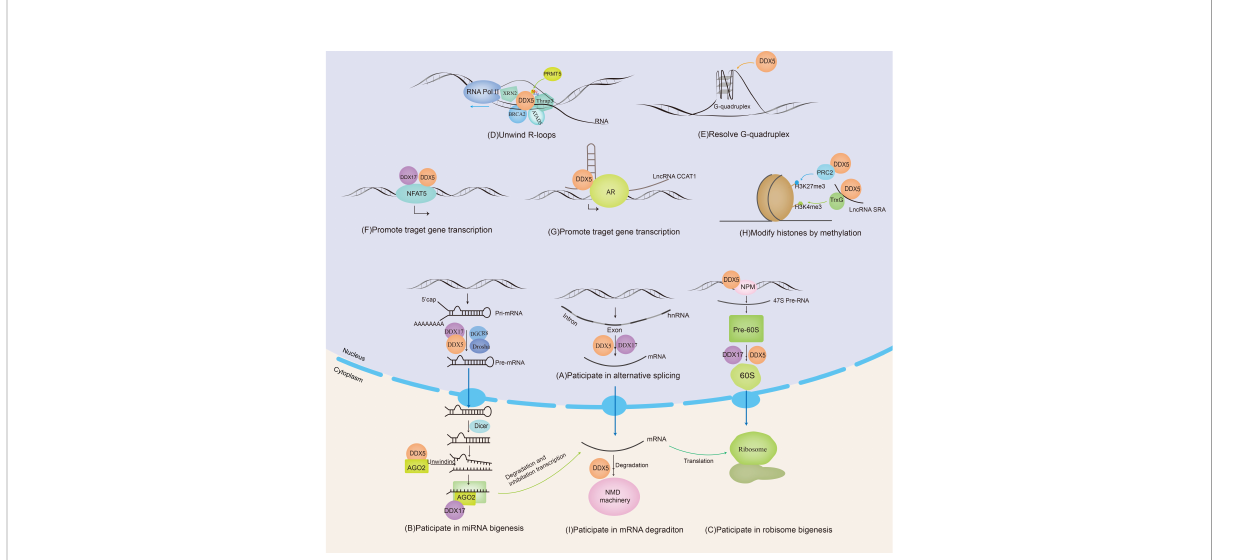
FIGURE 1 DDX5 and DDX17 are involved in RNA metabolism. DDX5/DDX17 are involved in ribosome synthesis, microRNA (miRNA) biosynthesis, regulation of mRNA alternative splicing, and the promotion or inhibition of mRNA transcription. DDX5 is also involved in nonsense-mediated mRNA decay (NMD), unwinding of R-loops and